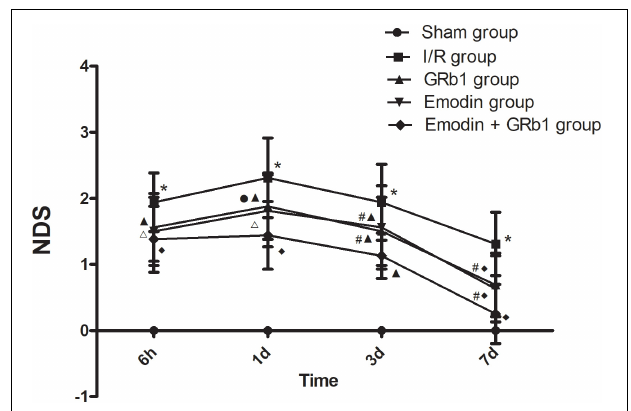
FIGURE 1 | The neurological deficits in different groups after I/R in rats (mean ± SD, n = 20). NDS in Sham group, I/R group, GRb1 group, Emodin group, and Emodin+GRb1 group at 6h, 1d, 3d, and 7d. Kruskal–Wallis test followed by the Mann–Whitney U test. ∗ p < 0.001, compared with Sham group. (cid:78) p < 0.05, (cid:77) p < 0.01, (cid:7) p < 0.001, compared with I/R group. # P < 0.05, • p < 0.01, compared with the Emodin+GRb1